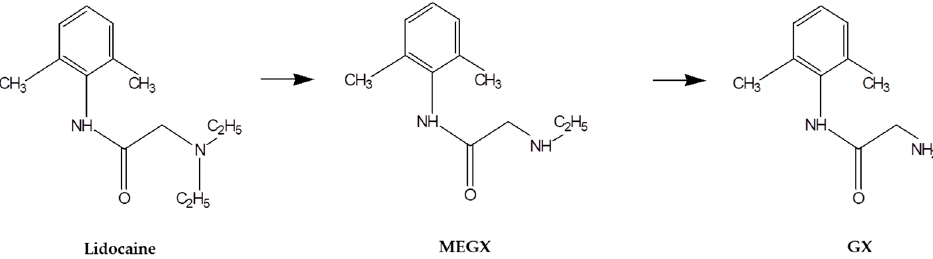
Figure 1. Lidocaine metabolism pathway.